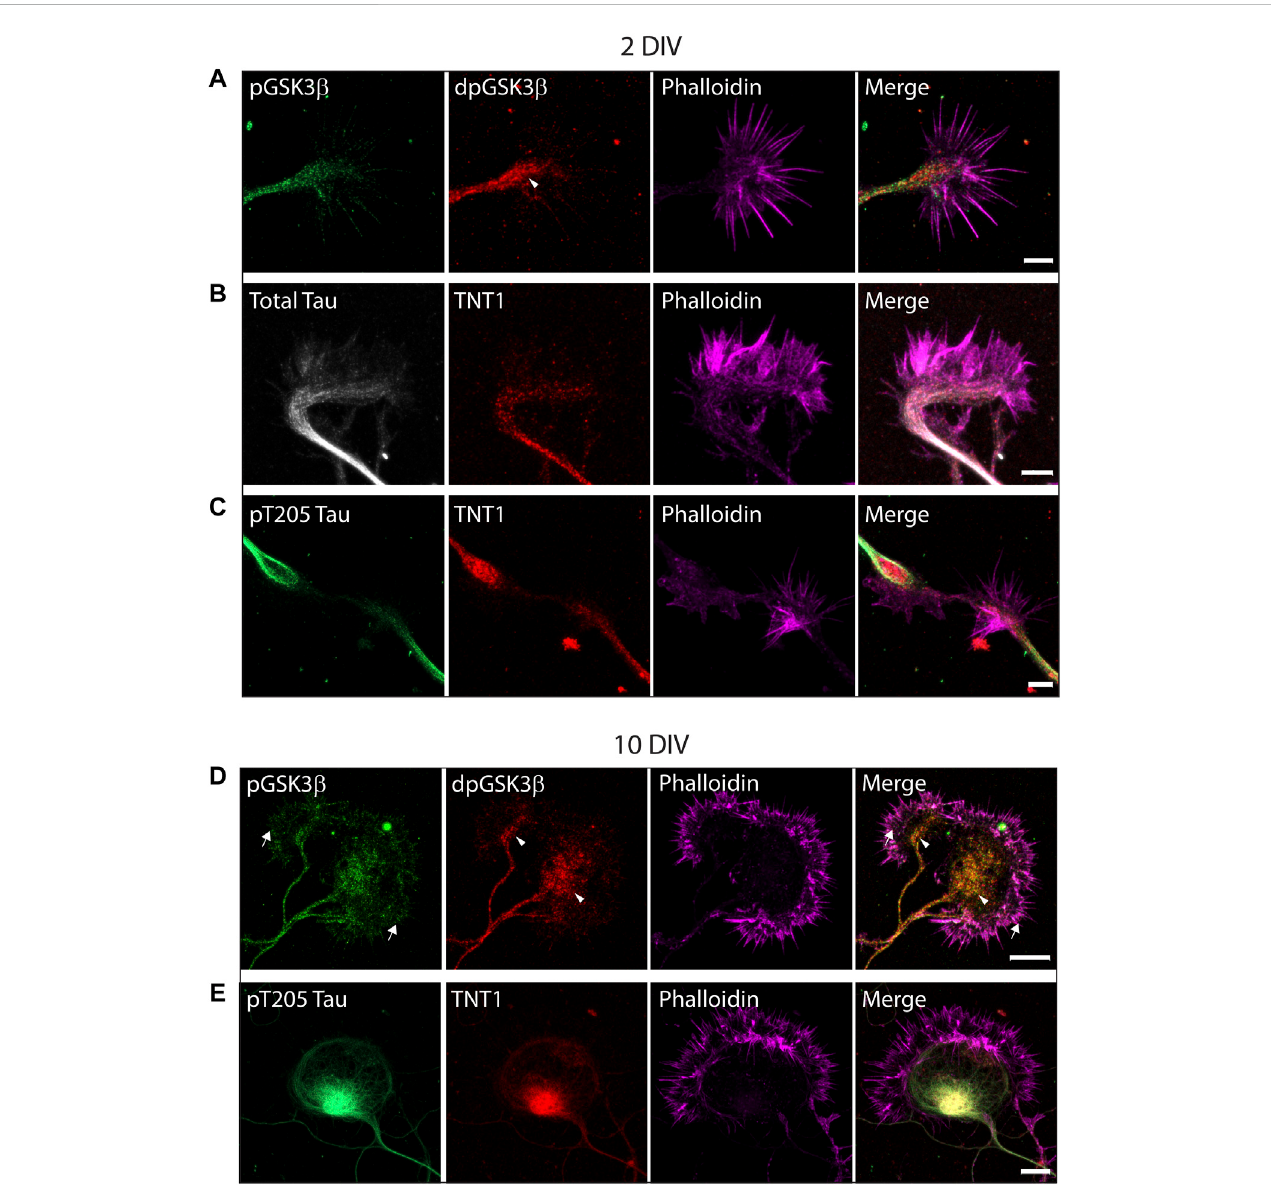
Active dp-Ser9-GSK3 β , PAD exposure, and pT205 tau are localized in growth cones. WT hippocampal neurons cultured for two DIV (A – C) or 10 DIV (D – E) wereimmunostainedforinactivephospho-Ser9-GS3 β (green)andactivedephospho-Ser9-GSK3 β (red) (A,D) orTNT1(red) (B,C,E) ,totaltau(white) (B) or pT205 tau (green) (C, E) . All neurons were also stained with phalloidin to visualize actin (magenta). (A,D) Active dpGSK3 β is enriched in the central region of the growth cone (arrowheads) whereas inactive pGSK3 β is evenly distributed along the growing neurite and throughout the growth cone (arrows). (C, E) At both early and late developmental timepoints, TNT1 and pT205 tau immunoreactivity are visible at the end of growing neurites and the central region of growth cones. Scale bars: 5 μ m (2 DIV); 10 μ m (10